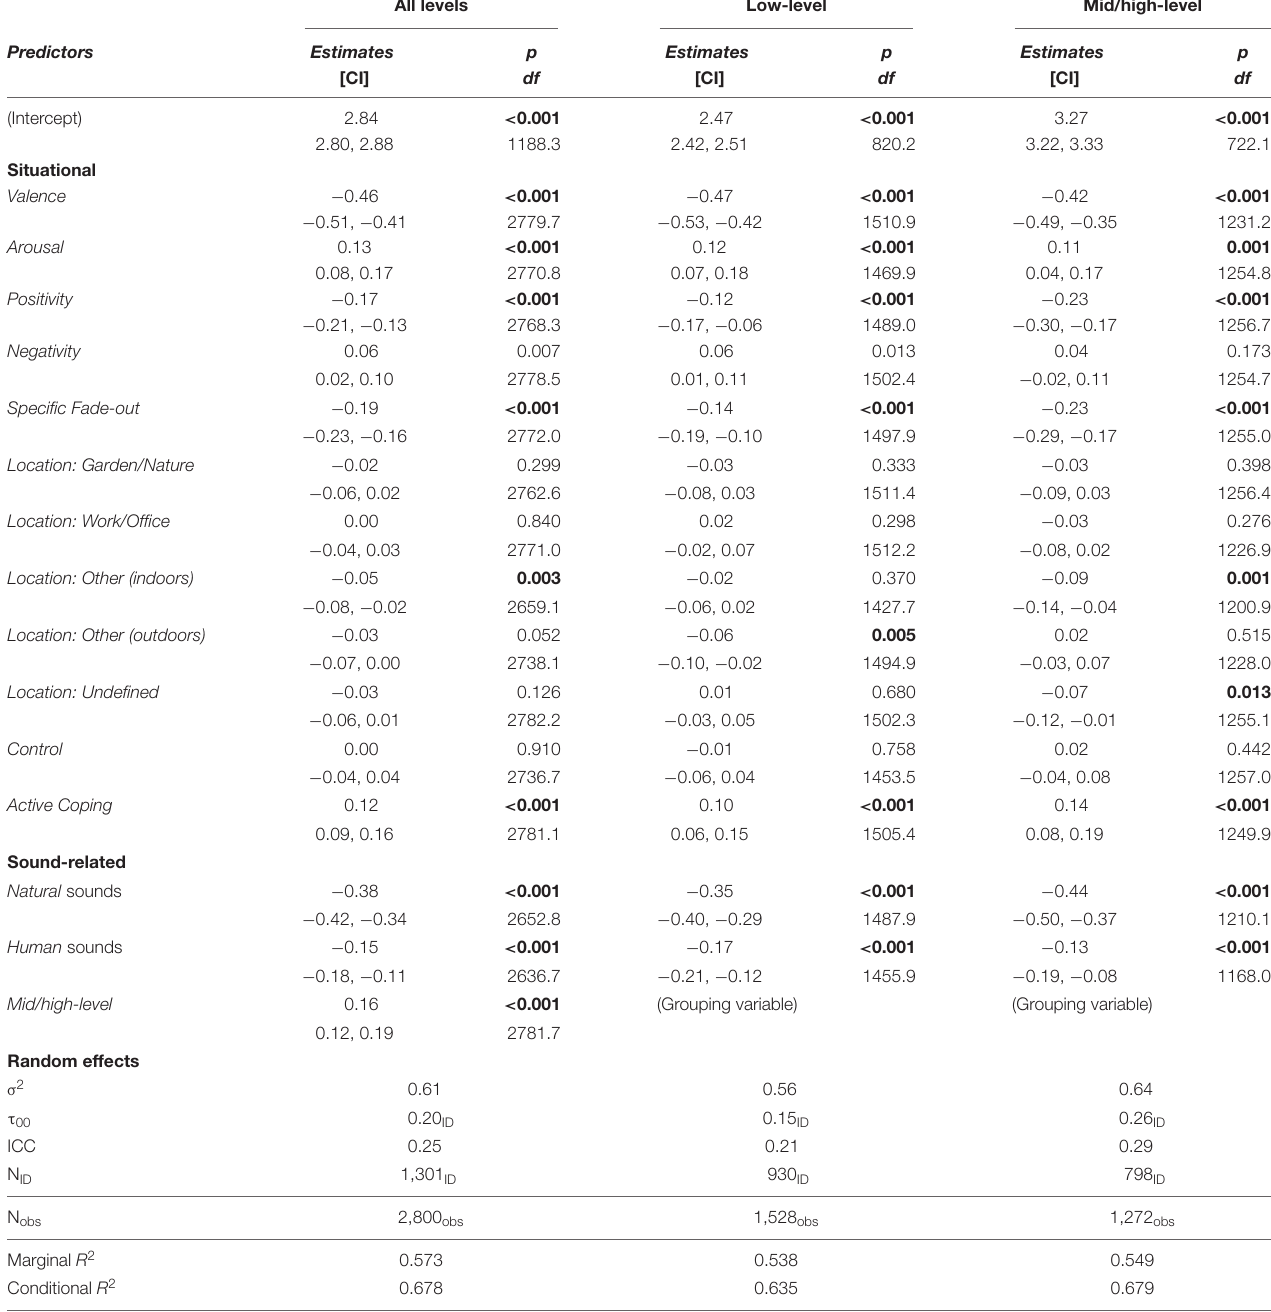
TABLE 7 | Comprehensive model of all parameters from the bivariate analyses that reached an R 2 m ≥ 0.050, respectively; with the full dataset and two Loudness subsets. All